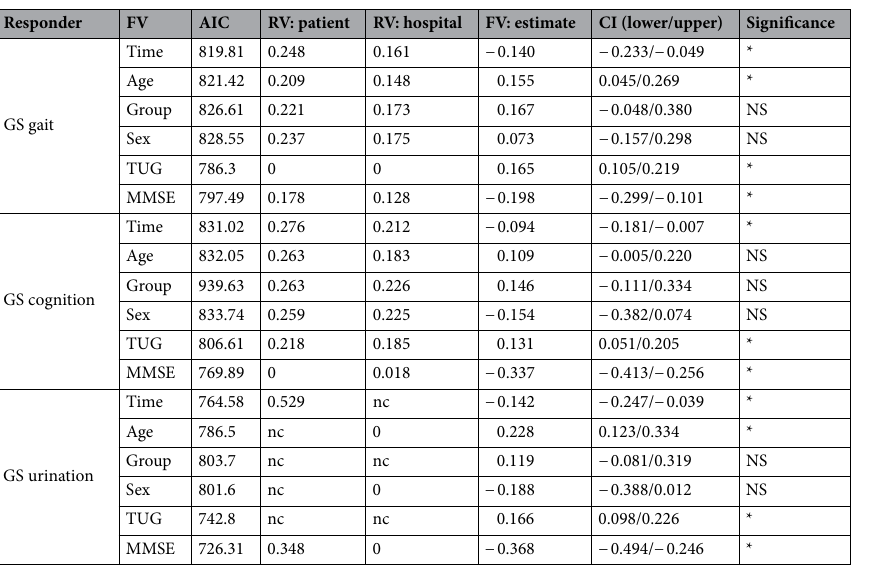
Table 3. Results in GLMM (2): GS gait, GS cognition and GS urination. AIC Akaike Information Criteria, CI 95% confidence intervals, FV fixed variable, GLMM generalized linear mixed model, GS iNPH grading